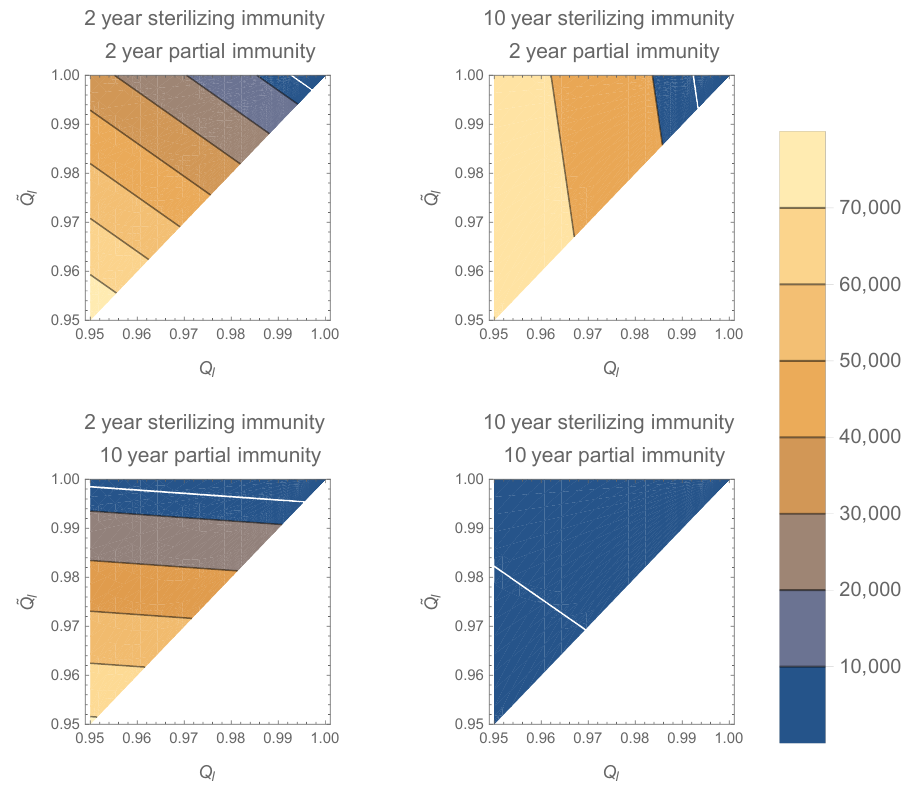
Figure 1. Contour plots of H ∗ in the model with two infection types for various Q l and ˜ Q l along the axes. The white line corresponds to H ∗ = 5000. As Q l and ˜ Q l approach 1, H ∗ decreases to 0 (top right corner of plots). If sterilizing immunity is long compared to partial immunity, H ∗ is more sensitive to increases in Q l , especially near 0. If partial immunity is long compared to sterilizing immunity, H ∗ is more sensitive to ˜ Q l , especially near 0. Increasing the duration of sterilizing immunity decreases H ∗ . All plots generated with R 0 = 2.5, N = 10 8 , Q h = 0, ˜ Q l = 0.8, and γ = 1/10 per